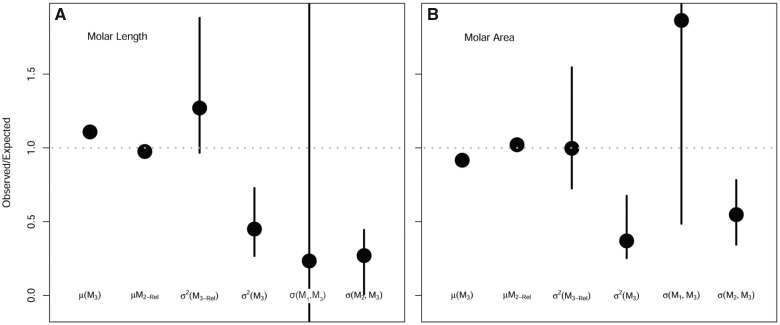
Plot comparing (A) MMC and (B) ICM predictions to direct estimates of six variables based on a sample of P. gossypinus following Roseman and Delezene (2019). The y axis measures the proportion of direct estimates fulfilled by predictions. Values higher than one are over-predicted by models. Values less than one are under-predicted. Black points indicate the mode of the posterior distribution and black lines indicate the 95% posterior credible interval. Values on the x axis, from left to right, indicate mean M3 size (µ[M3]), mean size of M2 as a proportion of total molar row size (µM2-Rel), variance of relative M3 size (σ2[M3-Rel]), variance of the absolute M3 size (σ2[M3]), covariance of M1 and M3 (σ[M1, M3]), covariance of M2 and M3 (σ[M2, M3]).